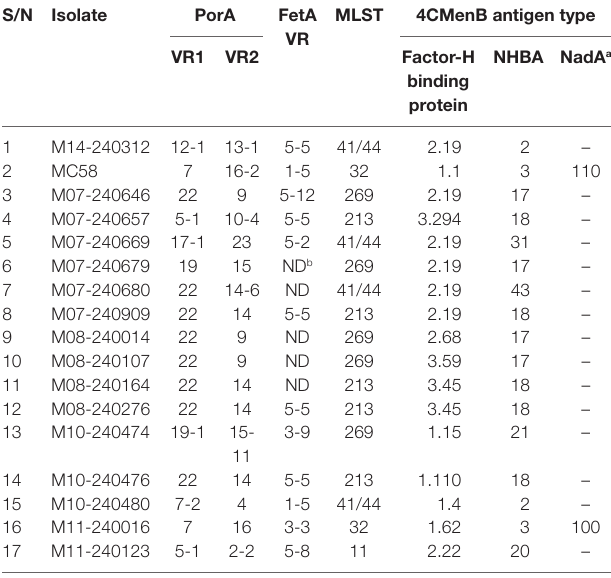
TaBle 1 | MenB strains composing the 17-strain screening